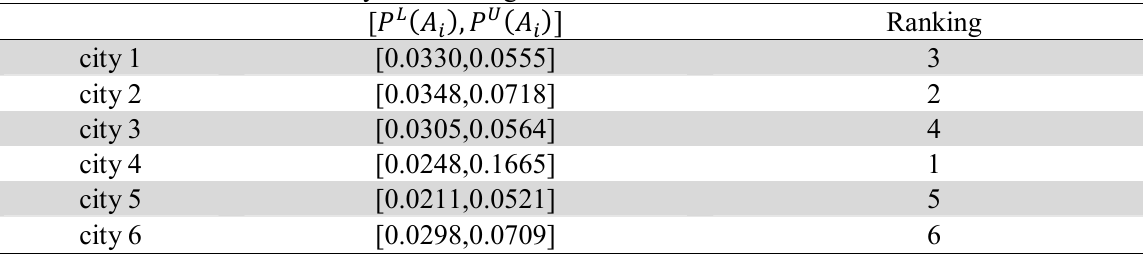
The calculation of interval utility and